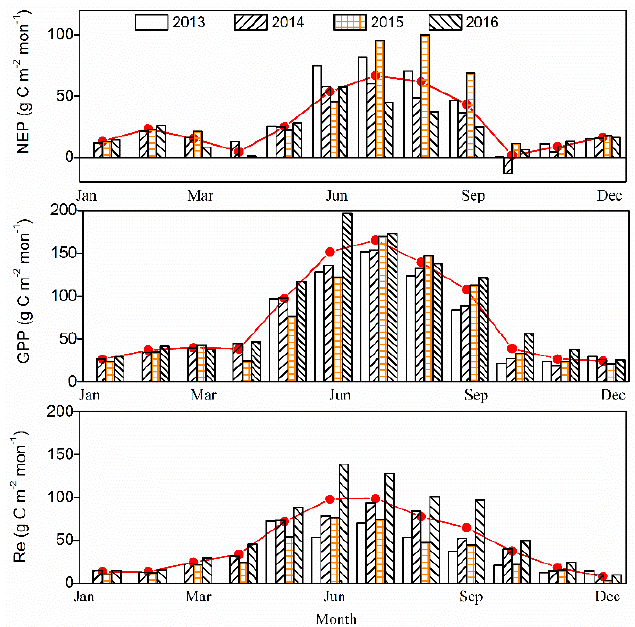
Figure 6. Monthly totals of C balance components: ( a ) net ecosystem productivity (NEP), ( b ) gross primary production (GPP), and ( c ) ecosystem respiration (Re) at the study site. The solid lines indicate mean values of NEP, GPP and Re for 2013–2016.